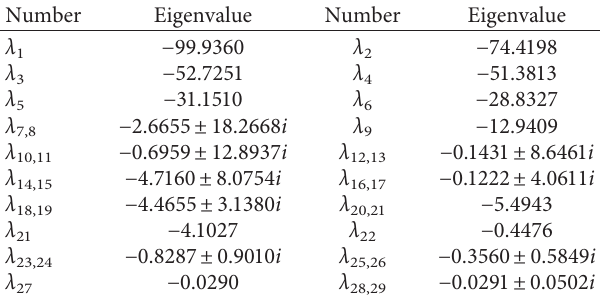
Table 1: Eigenvalues of the system during stable